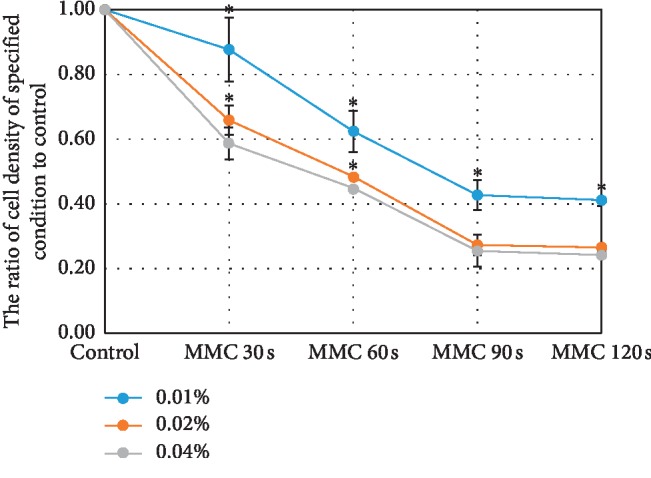
The cell densities in the 0.01% MMC group are higher than those in the 0.02% and 0.04% MMC groups under the condition of application time of 90 s (P < 0.05) or 120 s (P < 0.05). The cell densities in 4 conditions (0.02% + 90 s; 0.02% + 120 s; 0.04% + 90 s; 0.04% + 120 s) have no difference (P > 0.05). ∗Cell density in the specified group has a significant difference (P < 0.05) with that in the 0.04% MMC group, respectively.